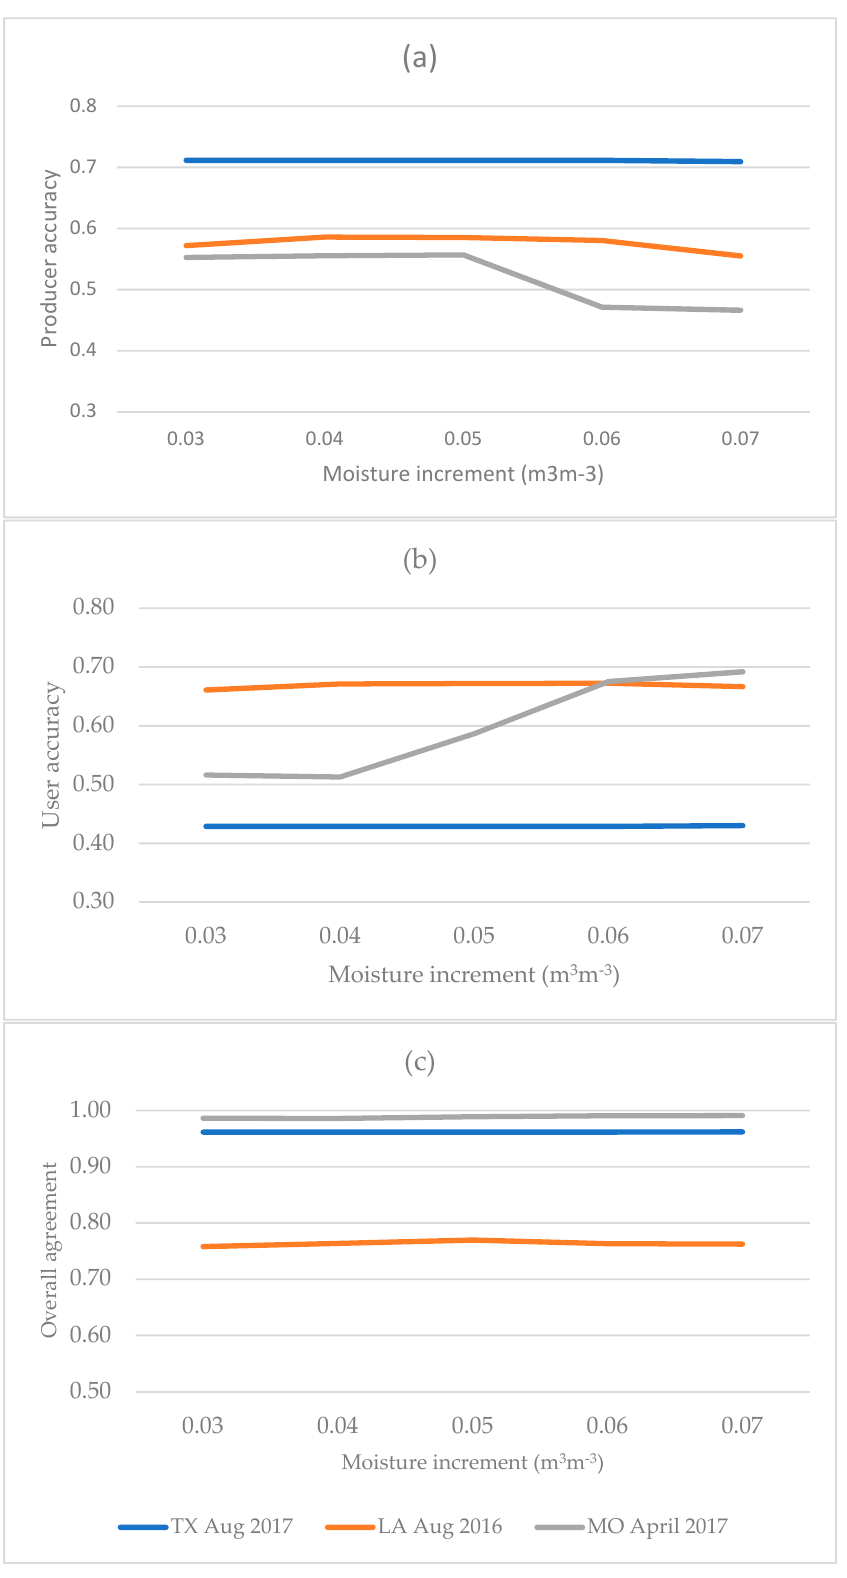
Figure 3. Sensitivity test of moisture increment threshold; ( a ) producer accuracy, ( b ) user accuracy, and ( c ) overall